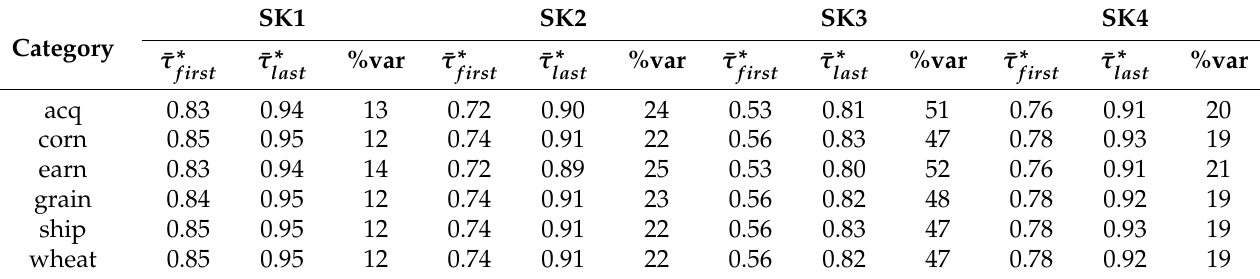
Table 3. Average of the computed collective concordance indices per category ( m =